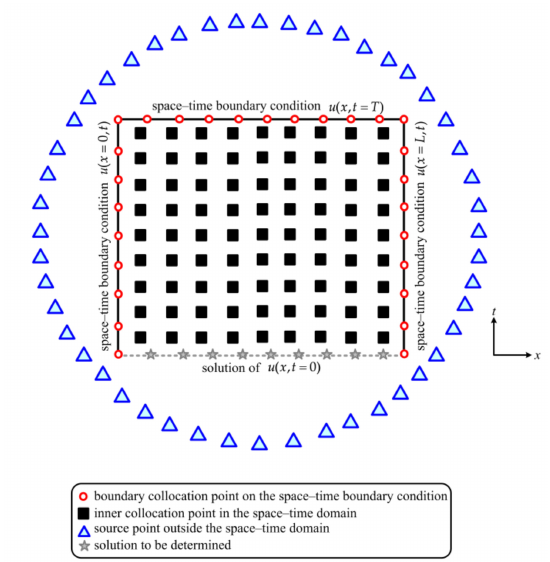
Figure 10. The collocation scheme for the BHCP.